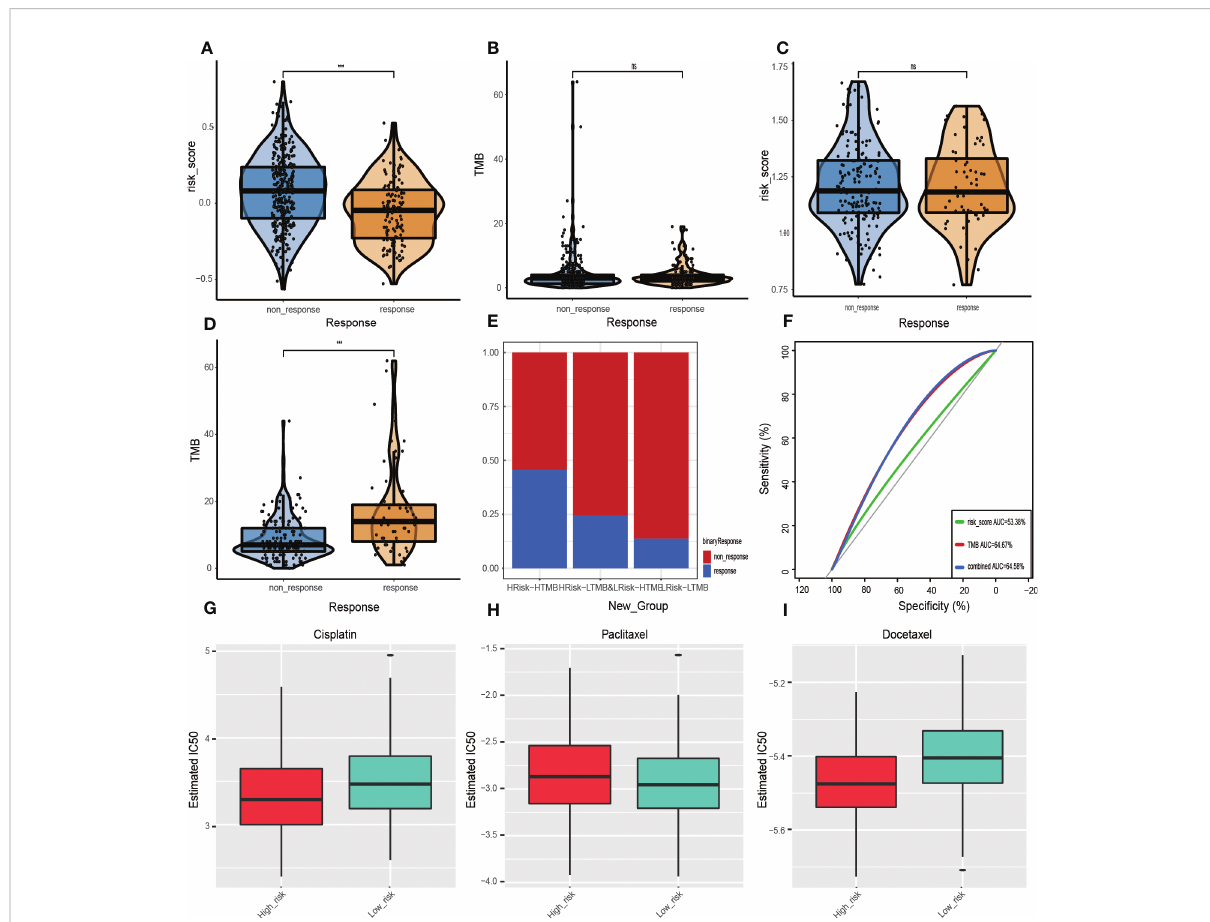
FIGURE 10 Prognostic value of ICI therapy. (A, B) Sizes of training cohort responses, non-response sample GRGPIs, and TMB values. (C, D) Differences in GRGPIs and TMB between responsive and non-responsive samples from IMvigor210. (E) Proportions of immunotherapy-responsive and non- responsive samples in the three subgroups from the IMvigor210 cohort. (F) ROC curves of GRGPI, TMB, and GRGPI combined with TMB in the IMvigor210 cohort. Analysis of drug sensitivity. Differences in IC50 values of (G) Ge fi tinib, (H) Erlotinib, and (I) Cisplatin in the high-GRGPI group and low-GRGPI